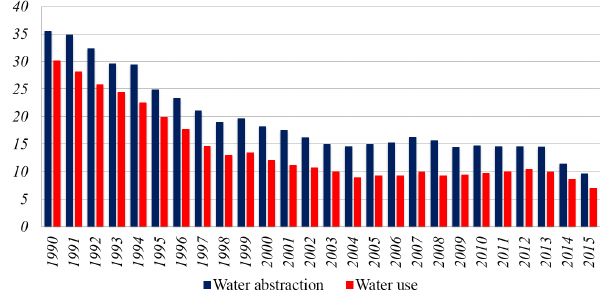
Figure 2. Water abstraction and water use in Ukraine, billionm 3